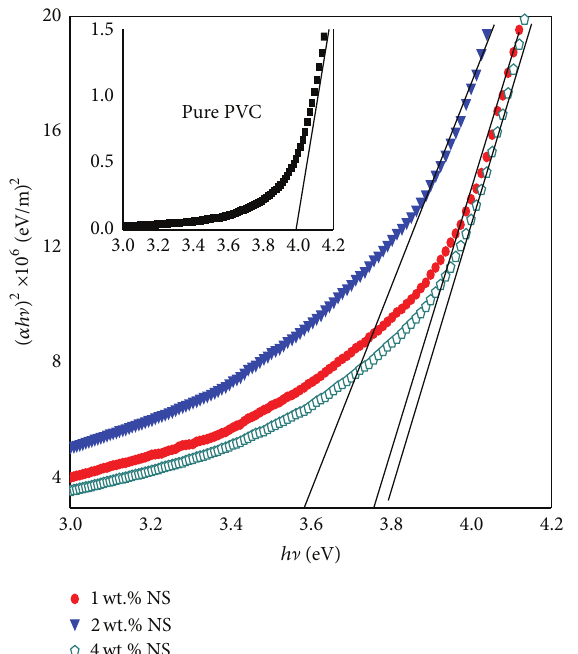
Figure 5: Plot of (𝛼ℎ ] ) 2 versus ℎ ] for pure PVC and PVC-SiO 2 nanocomposite films.